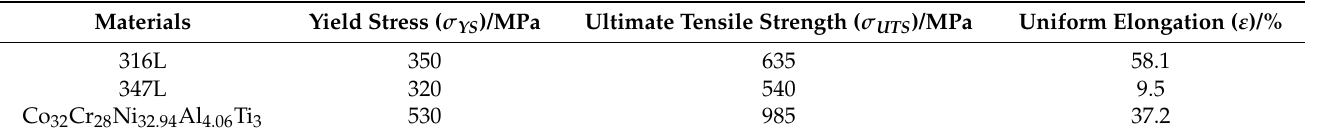
Table 3. Mechanical properties of three materials at room temperature.